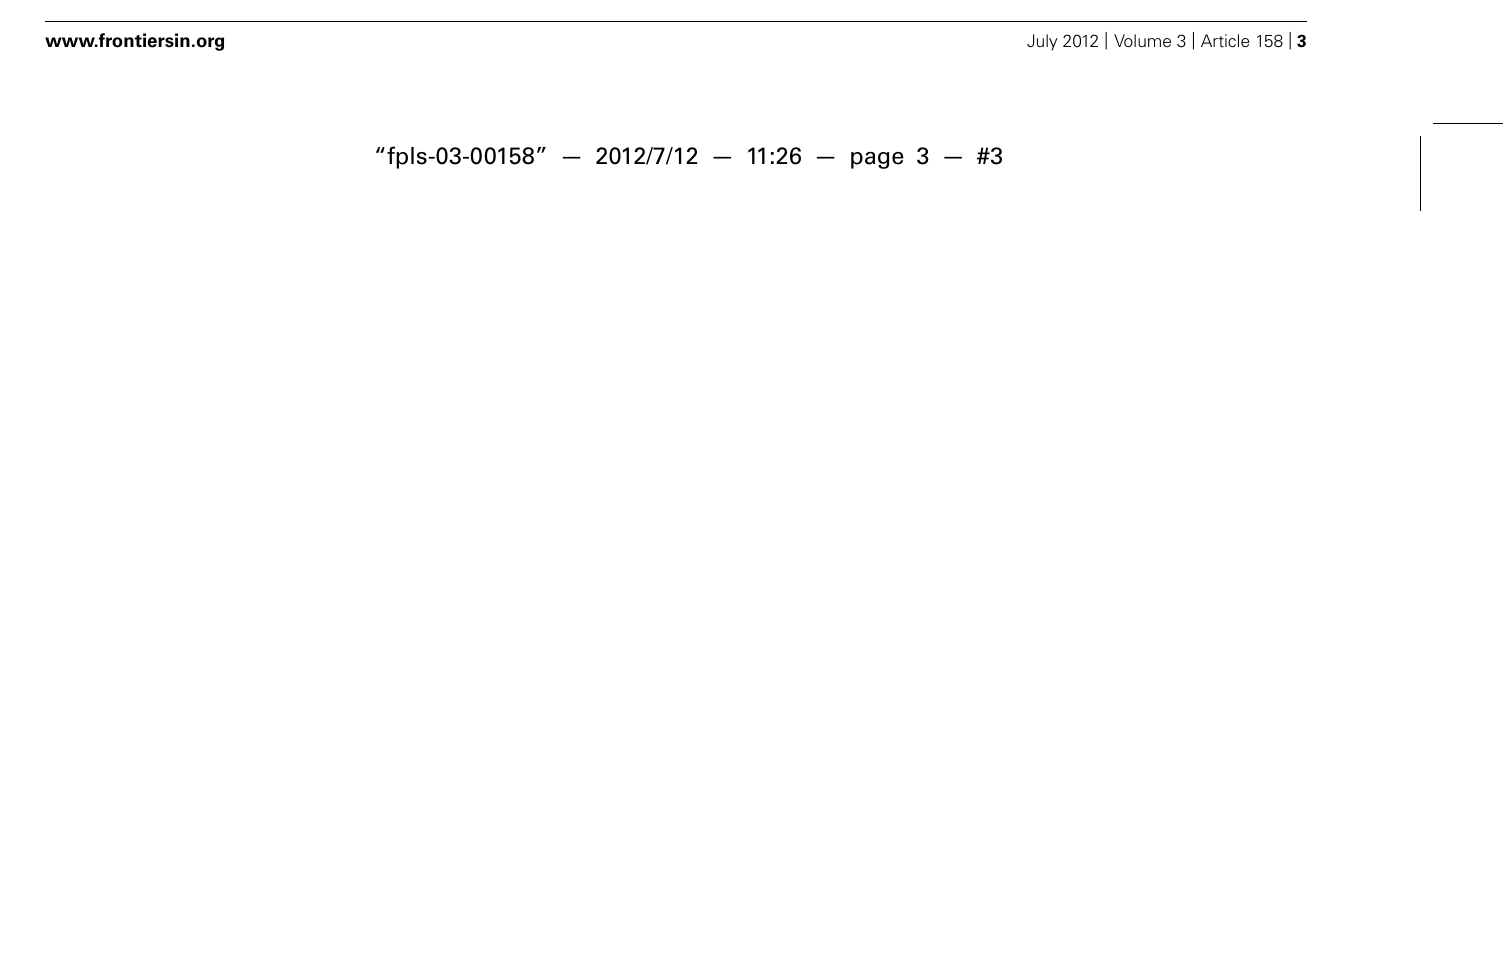
obtained fromTAIR. Kinesin motor domains, P-loop motifs, armadillo (ARM) repeats, and calponin homology (CH) domains were predicted using ScanProsite tool at Expasy (http://prosite.expasy.org/scanprosite). Coiled coil domains were predicted using Parcoil2 at MIT, with a cut off value P > 0.025 and minimum read of 28 (http://groups.csail.mit.edu/cb/paircoil2). Proteins are drawn to